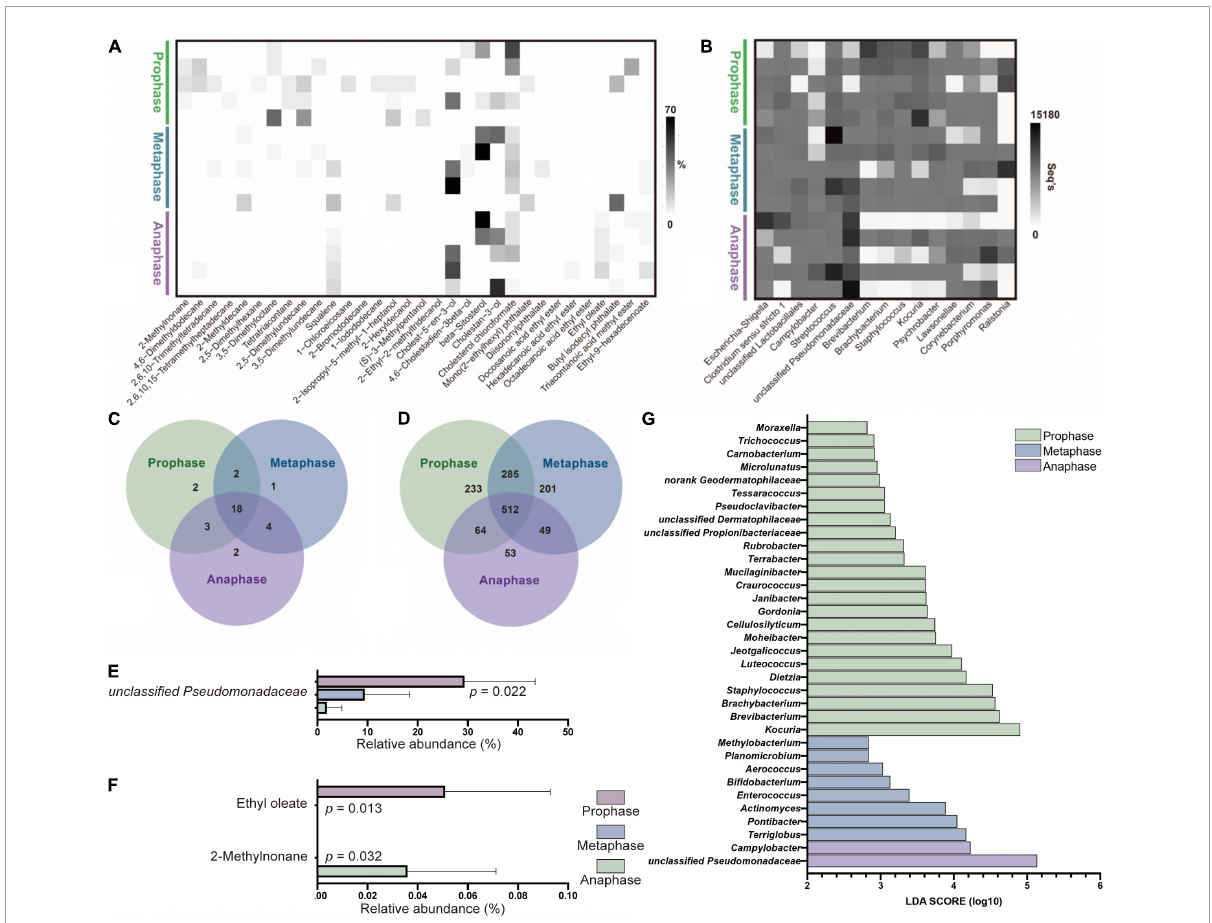
FIGURE4 The difference of bacterial and compounds’ profiles between different estrus phases of female panda AGM samples. (A) The odor core compounds abundance heatmap of AGM between prophase, metaphase and anaphase of female pandas during estrus ( n = 15). (B) The top 15 microflora community abundance heatmap on genus level of AGM between prophase, metaphase and anaphase of female pandas during estrus ( n = 15). (C) The unique and shared compounds between female giant pandas during prophase, metaphase and anaphase of estrus in AGM core compounds ( n = 15). (D) The unique and shared OTUs between female giant pandas during prophase, metaphase and anaphase of estrus ( n = 15). (E) The significant difference of AGM top 20 bacteria on genus level between prophase, metaphase and anaphase of female giant pandas during estrus ( n = 15). (F) The significant difference of AGM core compounds between prophase, metaphase and anaphase of female giant pandas during estrus ( n = 15). (G) The Liner Discriminant Analysis (LOA) analysis of AGM bacterial profiles between prophase, metaphase and anaphase stage of female pandas during estrus (The graph shows the LOA scores obtained from linear regression analysis of the significant microorganism groups in the three groups, n = 15. When the default LOA value ismore than 2 and the p value is less than 0.05, the result corresponds to a differential